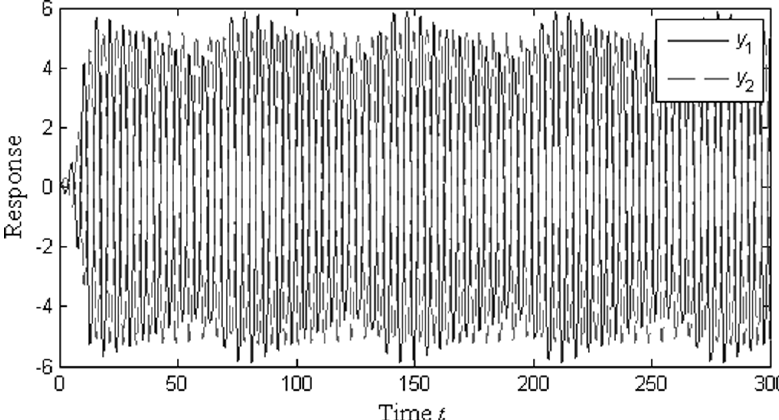
Fig. 20. Time history, Ω = 2.3 ( y 1 ,y 2 , ˙ y 1 , ˙ y 2 ) = (0.1,0.1,0,0).